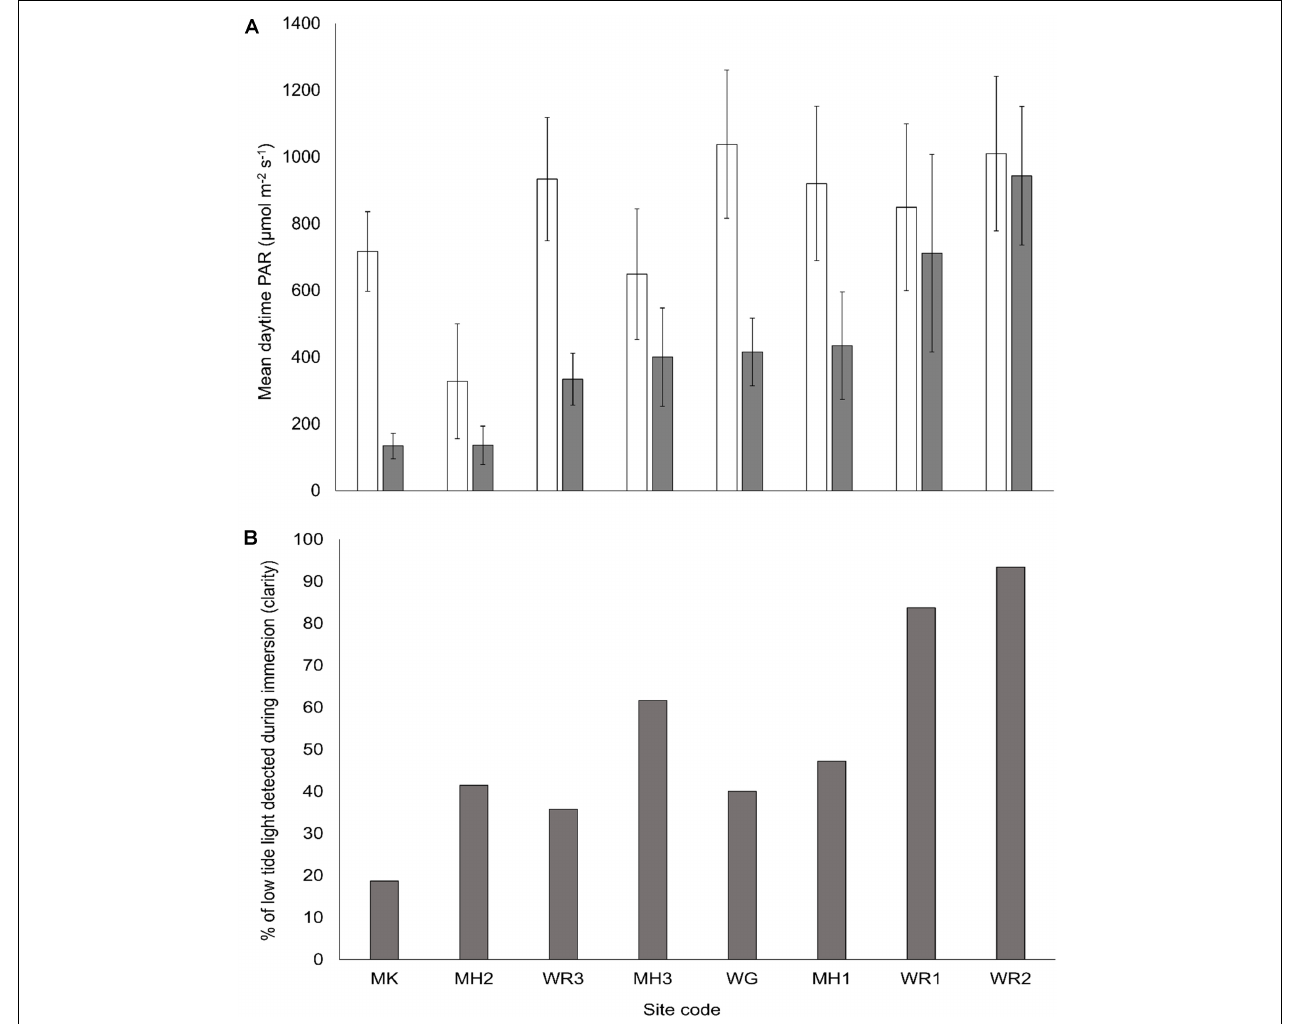
FIGURE 2 | (A) Mean daily photosynthetically active radiation (PAR, ± SE) measured 10 cm above the sediment surface for daytime low tide (white bars) and high tide (gray bars) for the 7 months period between the experiment setup and sampling. Daytime averaged from 2 h after sunrise to 2 h before sunset on days when low tides corresponded with daylight hours. (B) Relative clarity at each site over the 7 month period. Values close to 100% indicate the majority of incident light (emerged sensors) is detected by the submerged sensor (during immersion periods). Values close to zero mean very little incident light is reaching the submerged